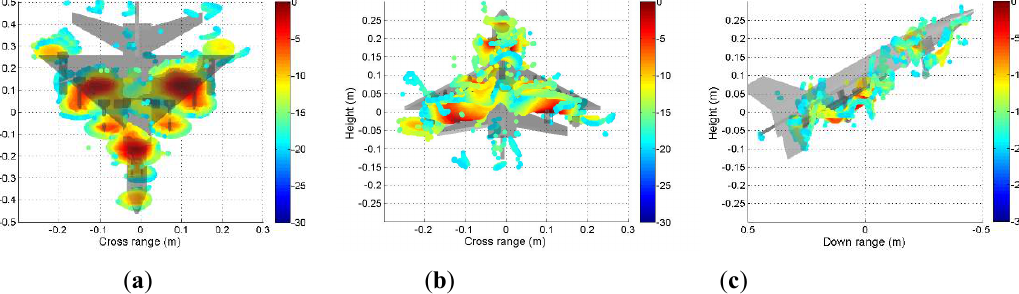
Sensors 2019 , 19 , x FOR PEER REVIEW Figure 9. Four 2D images obtained from a single baseline: ( a ) HH, ( b ) HV, ( c ) VH, and ( d ) VV.